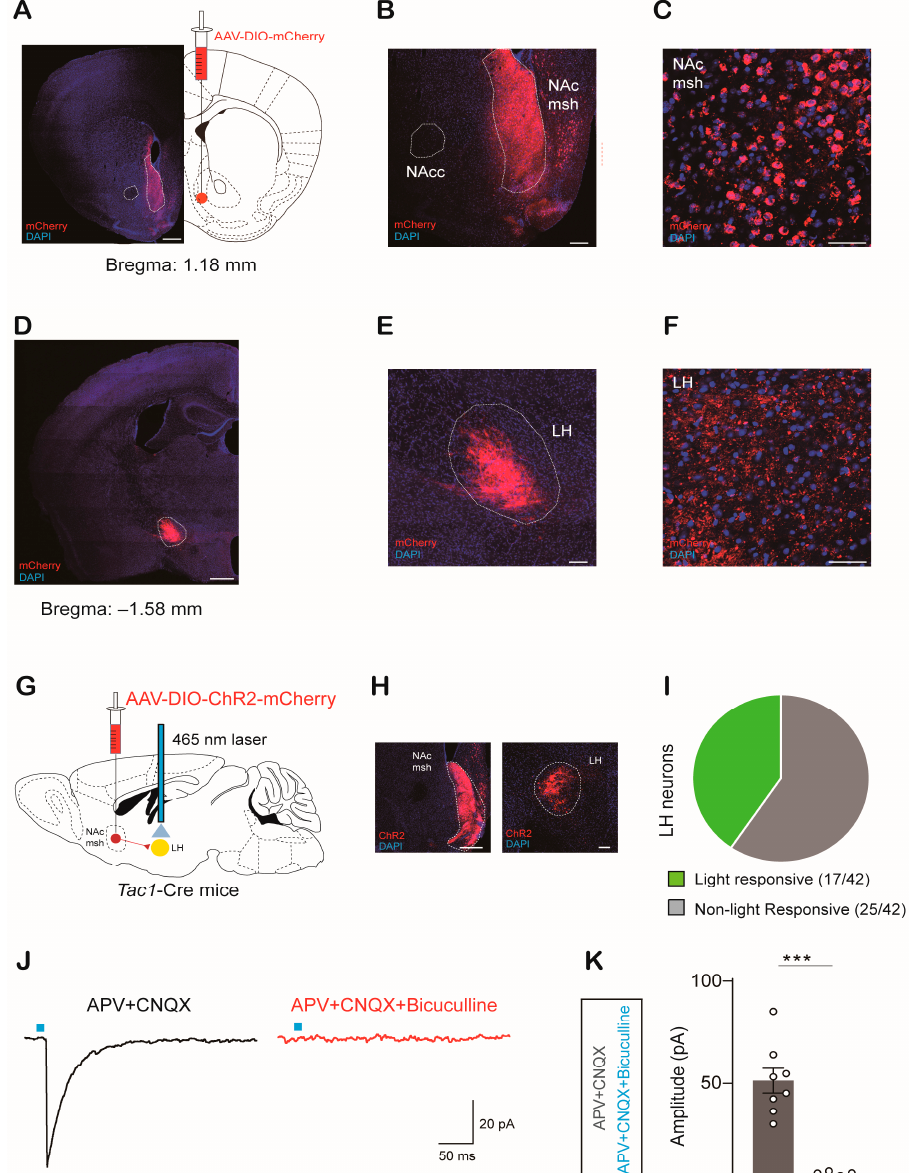
Figure 2. Output mapping of Tac1 neurons in the NAc medial shell: ( A ) Representative images showing virus expression in the NAc medial shell. Scale bar: 500 µm. ( B , C ) Coronal view documenting viral expression in NAc medial shell. Scale bar: 200 µm and 50 µm, respectively. ( D ) Images of tracing output from the NAc lateral shell to LH. Scale bar: 500 µm. ( E , F ) Anterograde tracing of Tac1 NAc neurons showing fibers in the LH. Scale bar: 200 µm and 50 µm, respectively. ( G ) Schematic of strategies used to express AAV-DIO-ChR2-mCherry in Tac1 neurons. ( H ) Representative images of injection and projection sites. Scale bar: 200 µm. ( I ) Pie chart indicating that oIPSCs were recorded in 40% of cells (17 of 42 cells), and 60% were non-responsive in 3 mice. ( J ) The GABA-A receptor antagonist bicuculline totally inhibited oIPSCs in the LH neurons induced via optical stimulation. ( K ) Average amplitude of oIPSCs recorded (two-tailed paired t -test, t 12 = 6.396, p < 0.0001). APV+CNQX: N = 3, n = 8; APV+CNQX+Bicuculline: N = 3, n = 6. N: animal number; n: cell number. NAcc: nucleus accumbens core; NAc msh: nucleus accumbens medial shell; LH: lateral hypothalamic area. All data are means ± s.e.m. *** p < 0.001.